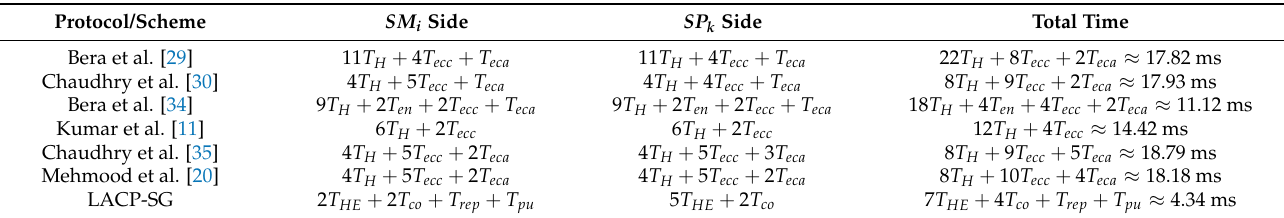
Table 7. Computational overhead